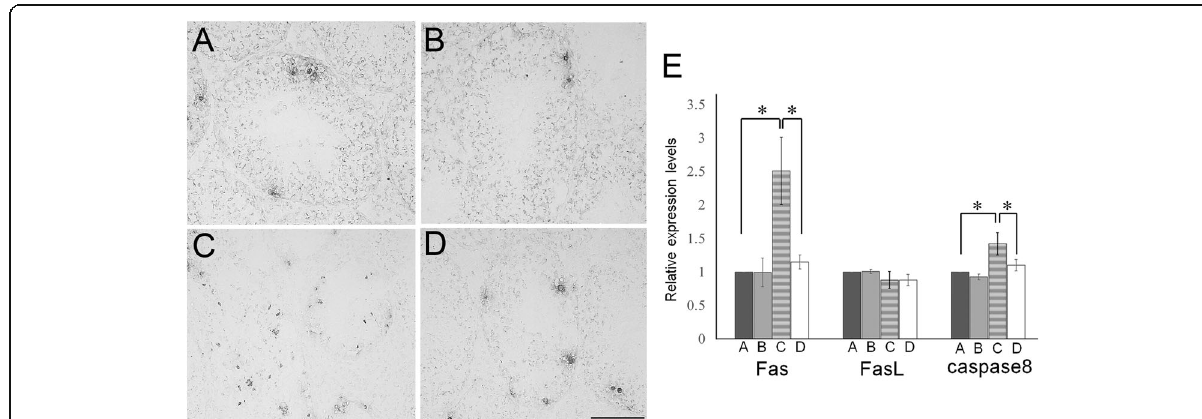
Fig. 4 Detection of apoptotic markers in cells of the testes after irradiation and TJ107 treatment. Spermatogenic cell apoptosis was assessed at day 120 in each group. Group A a , Group B b , Group C c and Group D d histological detection showed TUNEL staining in the testicular sections. Erratic round-shaped black areas in the seminiferous tubules indicate TUNEL-positive cells. Bar = 100 μ m. e Expression of Fas , Fas ligand ( FasL ), and caspase8 mRNA in mouse testes of each group at 120 days. Calculation of Relative mRNA intensity was done and the expression in the control group for each point was set to 1. The data are presented as mean ± standard deviation ( n = 10). Asterisks indicate p < 0.05